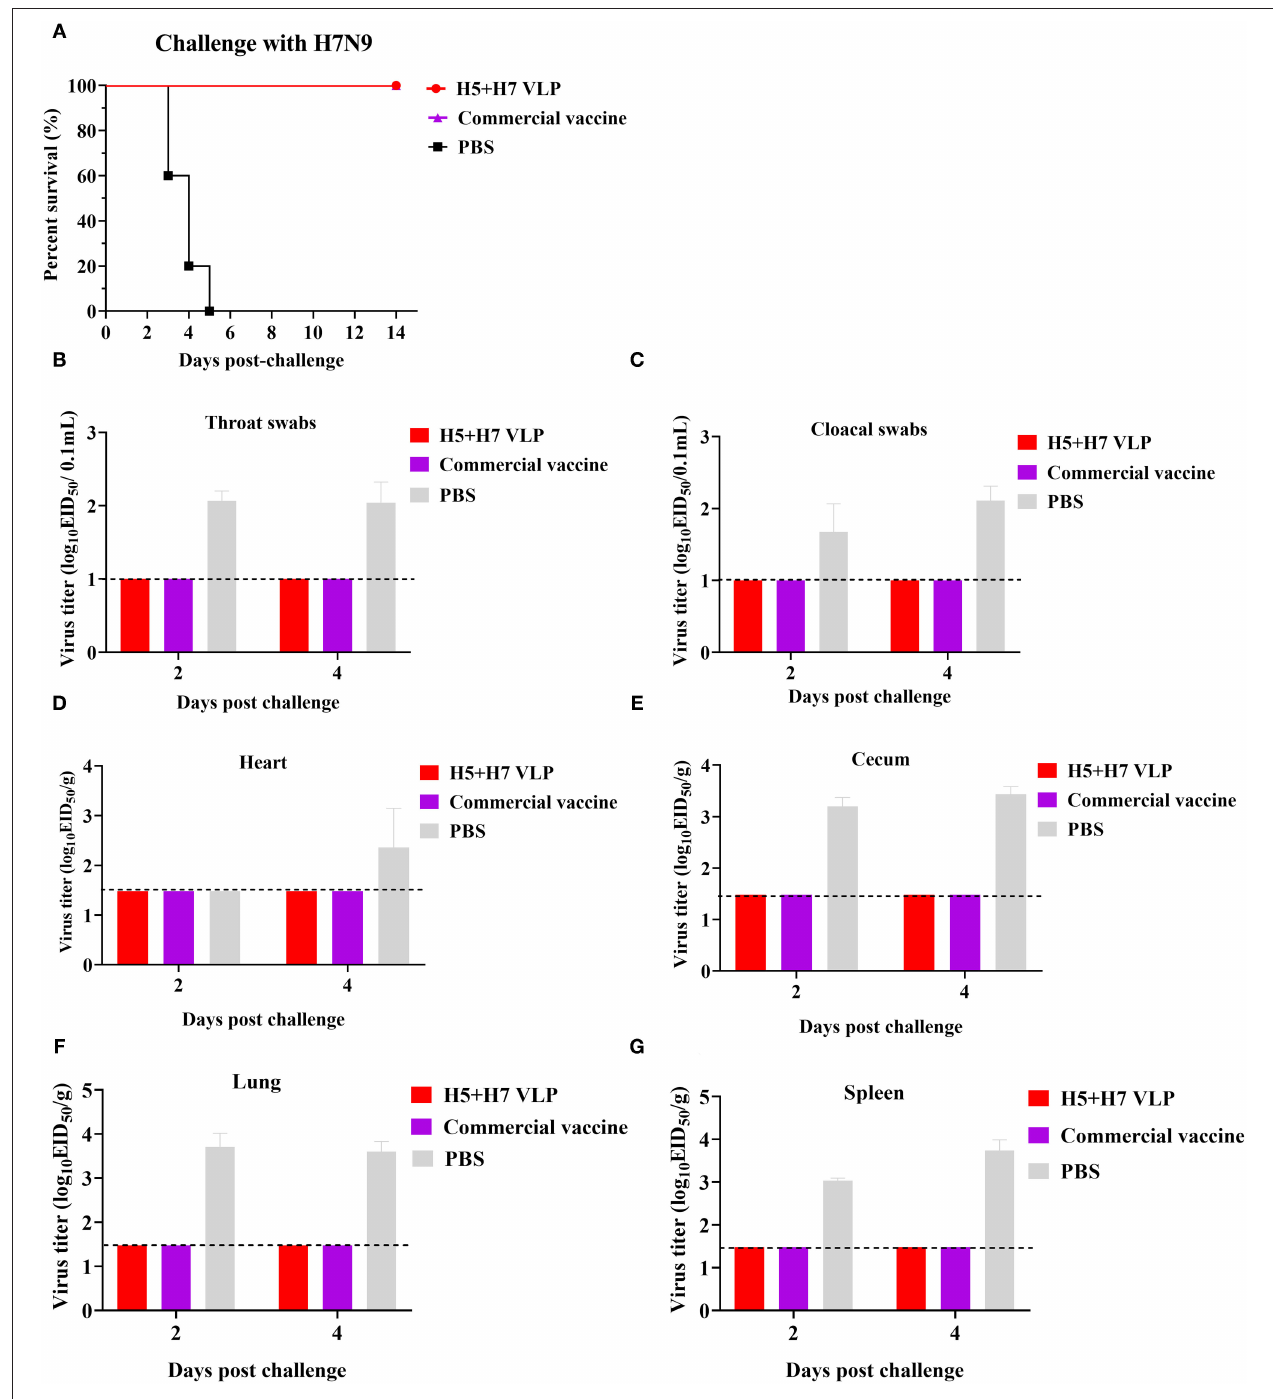
FIGURE 5 | The bivalent H5 + H7 VLP vaccine confers good protection against the lethal H7N9 virus. Chickens were i.m. immunized with 15 µ g of the bivalent H5 + H7 VLP or 0.3mL of the commercial trivalent (H5: Re-11; H5: Re-12; H7: Re-3) vaccine. (A) Survival rates of the birds after challenged with 10 6.0 EID 50 of the H7N9 GD15 virus. (B) Virus titration in laryngotracheal swabs on Day 2 and 4 p.c. (C) Virus titration in cloacal swabs on Day 2 and 4 p.c. Viral titers in the heart (D) , cecum (E) , lung (F) , and spleen (G) of the birds on Day 3 and 5 p.c. Viral titers were determined by measuring EID 50 . The detection limit was below 10 1.0 EID 50 /0.1mL for swabs and 10 1.48 EID 50 /g for